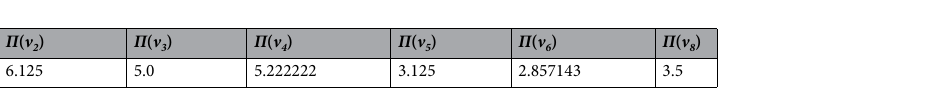
Table 4. Local influence values of node v 1 and its adjacent nodes. Nodes v 2 and v 4 have the same degree and Ks values, but different similarity coefficient values, so their contribution values to node v i differ. Thus, it improves the discrimination degree values of the neighboring